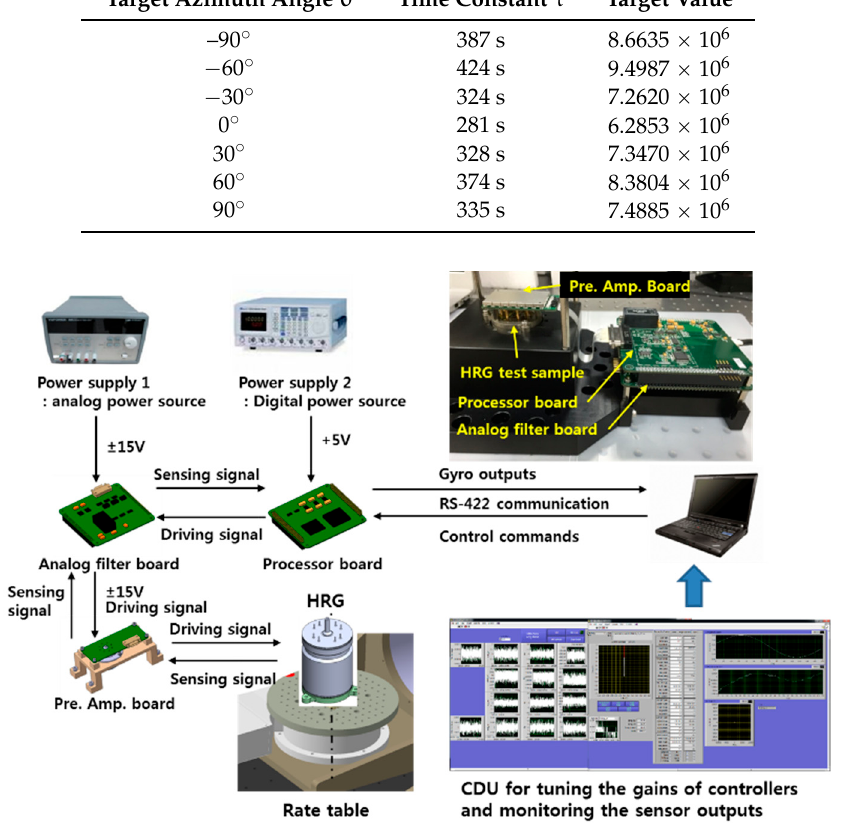
Figure 15. Test set for verification of the signal processing and control algorithm.